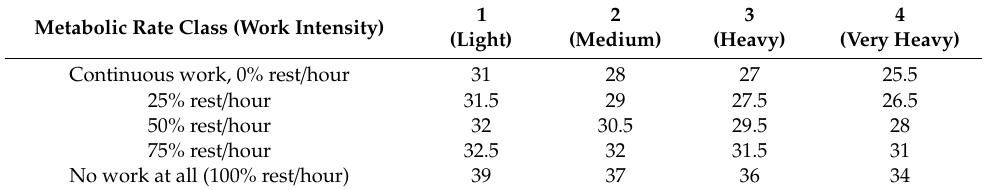
Table2. RecommendedmaximumWetBulbGlobeTemperature(WBGT)exposurelevels( ◦ C)atdi ff erent work intensities and rest / work ratios for an average acclimatized worker wearing light clothing. Source: compiled by Kjellström et al. 2009 from the International Organization for Standardization (ISO) 18 and the National Institute for Occupational Safety and Health (NIOSH) (criteria for a